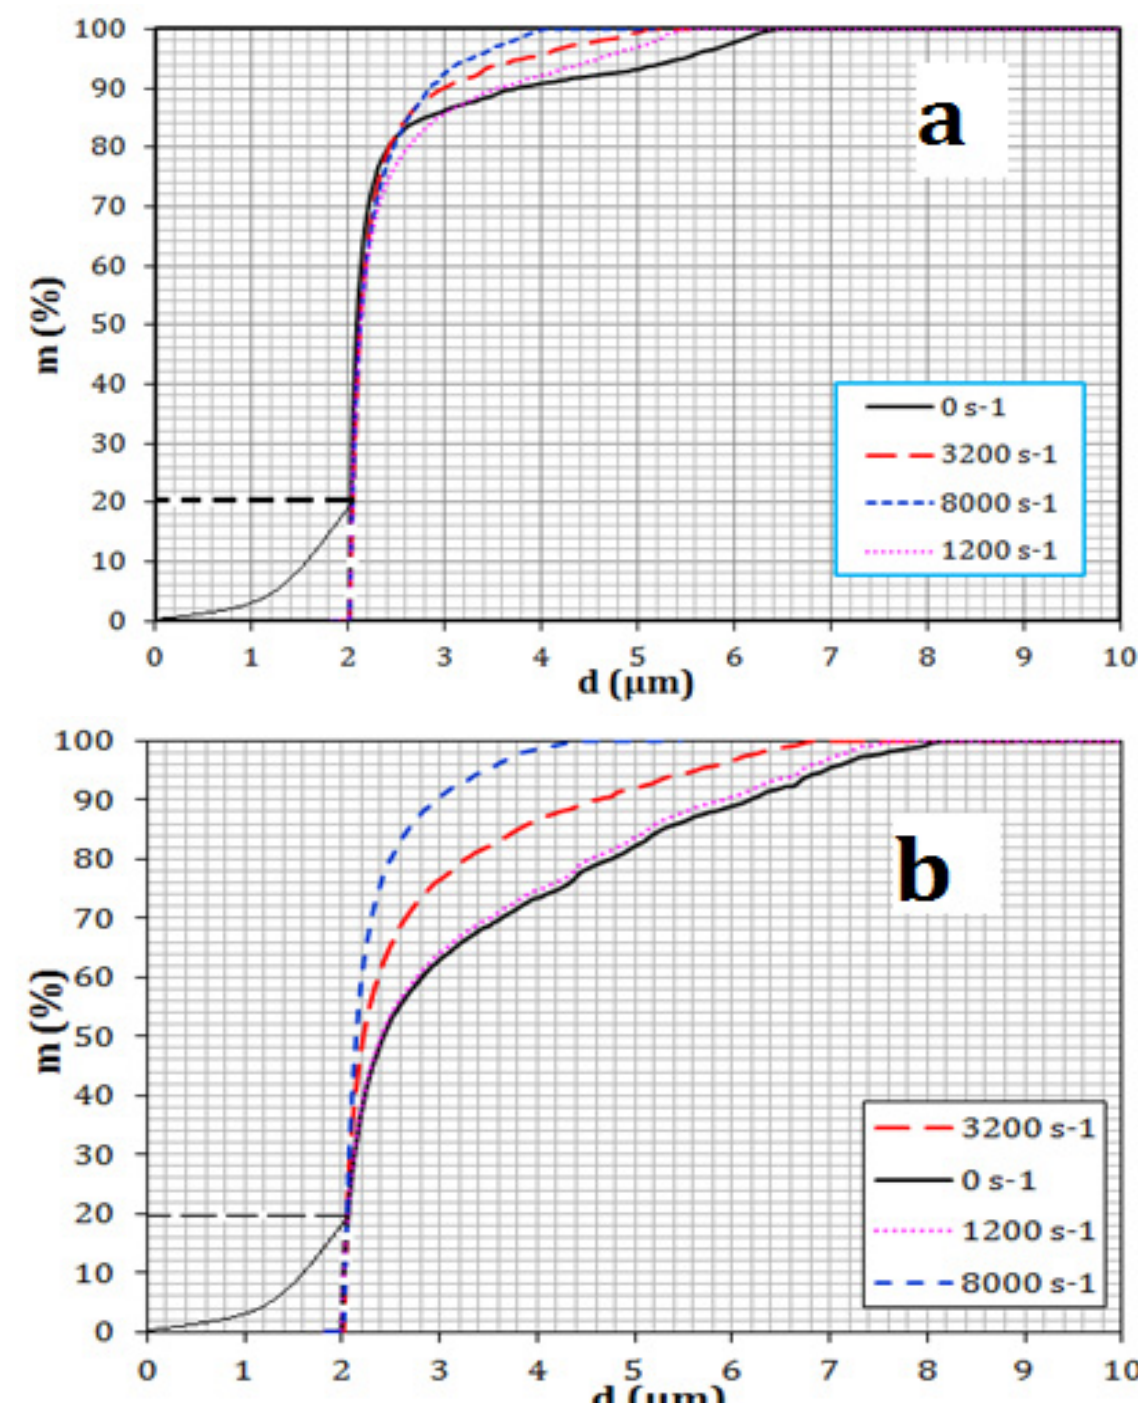
Figure 5. Size distribution of the mass of oil droplets stabilized by Tween 20 in the permeate at ( a ) at 200 lm -2 h -1 . and ( b ) 1000 lm -2 h -1 . [44].